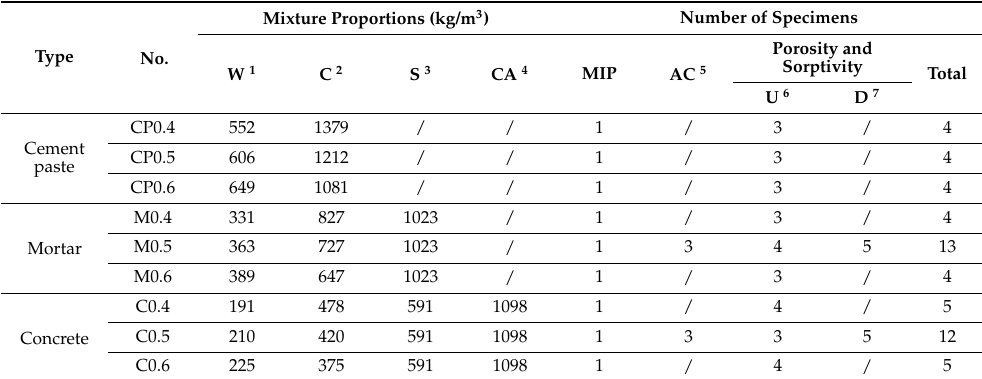
Table 1. Mixture proportions and number of